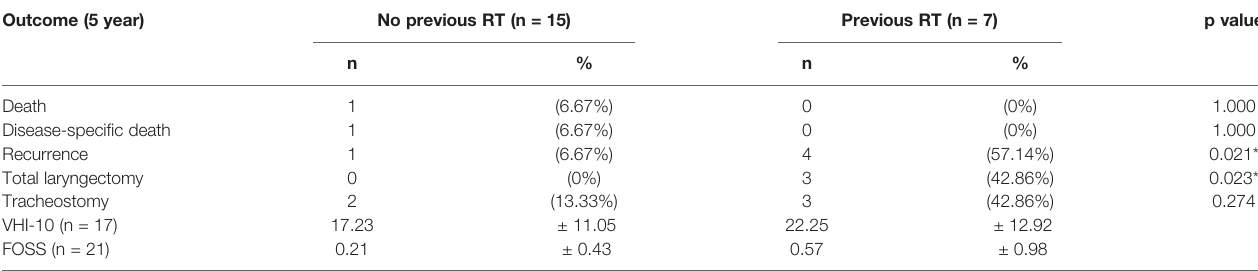
TABLE 3 | The outcomes of 22 patients and the differences between patients with and without previous history of radiotherapy. Outcome (5 year)